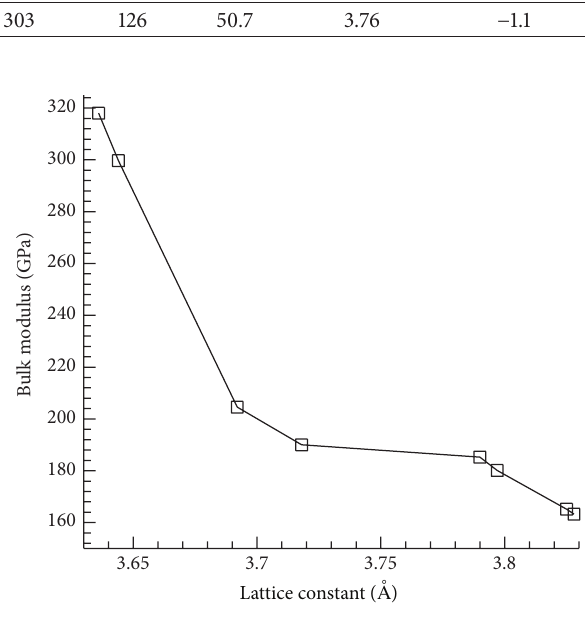
Figure 7: Dependence of bulk modulus on lattice